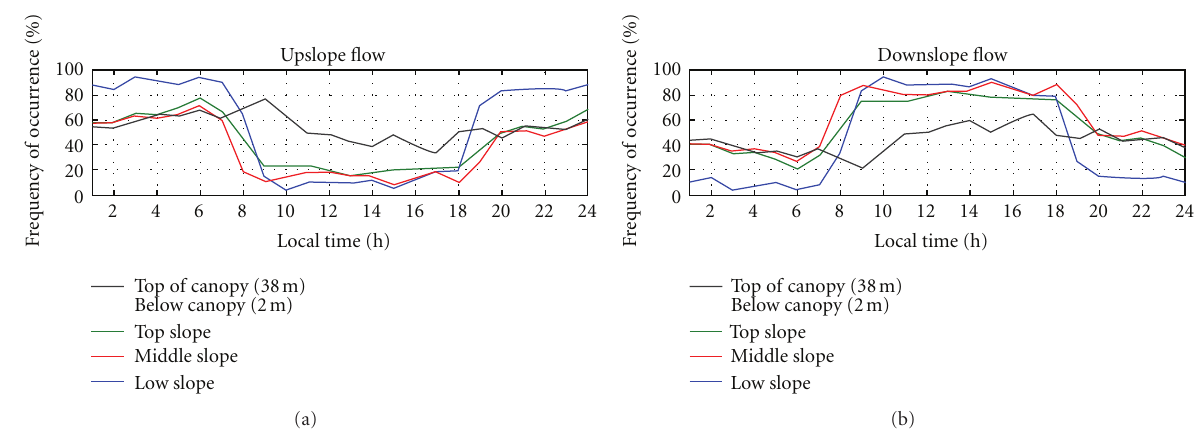
Figure 13: Frequency distribution of the subcanopy wind direction (a) upsloping (from north quadrant) and (b) downsloping (from south quadrant) on the south face slope area at the DRAINO horizontal array system (see Figure 4).